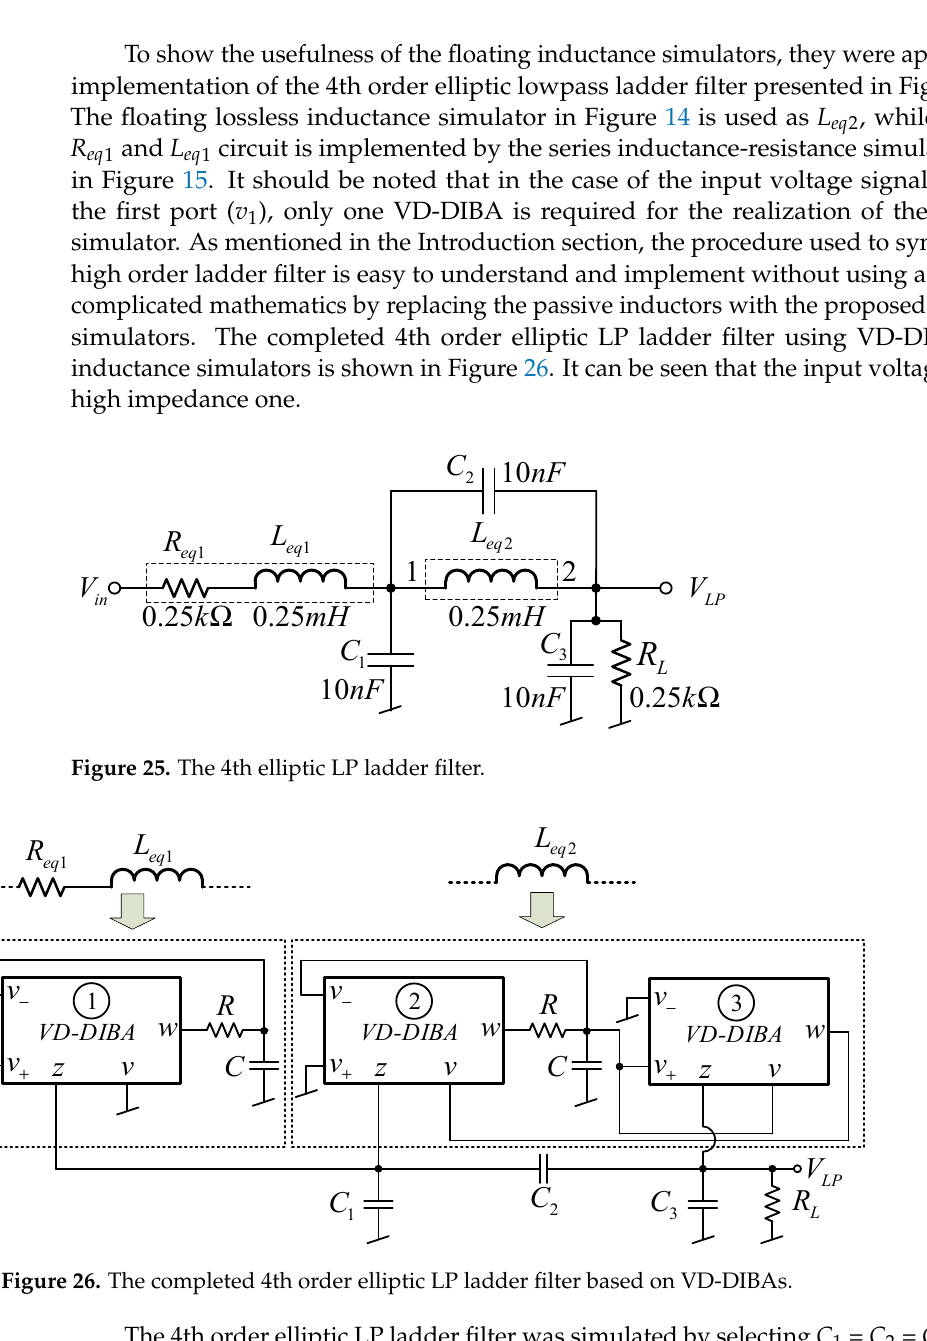
Figure 24. The frequency responses of the parallel L-R connection with different R set .